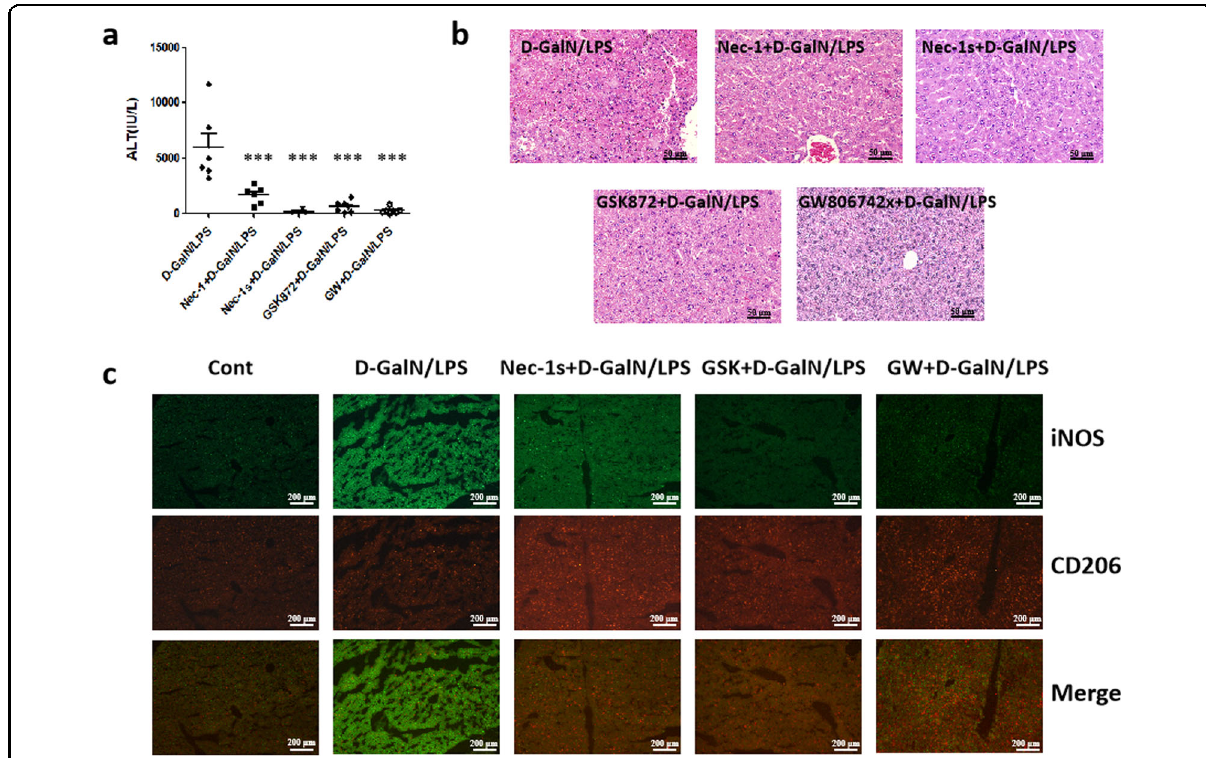
Fig. 1 Necroptosis inhibition reduces acute hepatic injury triggered by D-GalN/LPS, which is closely related to M2-like activation of macrophages. a The hepatic damage assessed by serum ALT levels in mice challenged by D-GalN/LPS with or without necroptosis inhibitors. *** P < 0.001 compared with acutely injured mice. ( n = 4 – 7) b The hepatic damage assessed by histopathology with H&E staining in mice challenged by D-GalN/LPS with or without necroptosis inhibitors. c The expression of M1 macrophage activation marker iNOS and M2 macrophage activation marker CD206 was detected by immuno fl uorescence in mice receiving D-GalN/LPS insult with or without necroptosis